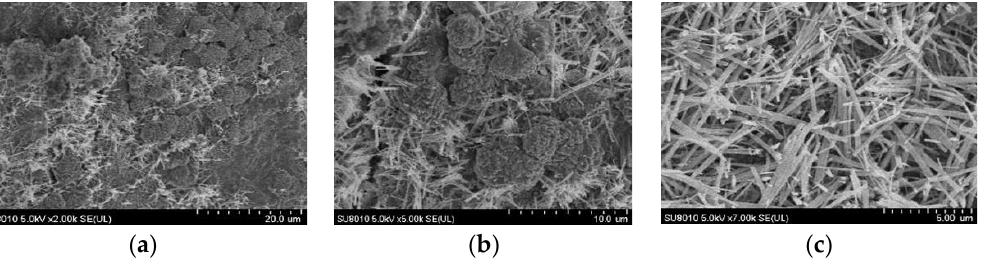
Figure 12. SEM images of concrete after freeze – thaw cycles in a 6.8% composite salt solution with an initial load of 0.3 f . ( a ) 2000 ×. ( b ) 5000 ×. ( c ) 7000 ×.